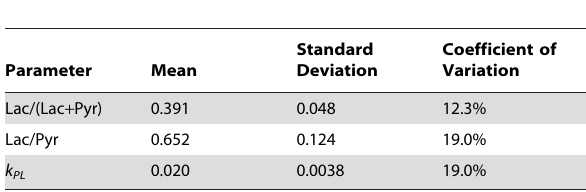
Table 1. The mean, standard deviation and coefficient of variation for all repetitions (N =7) of the dynamic